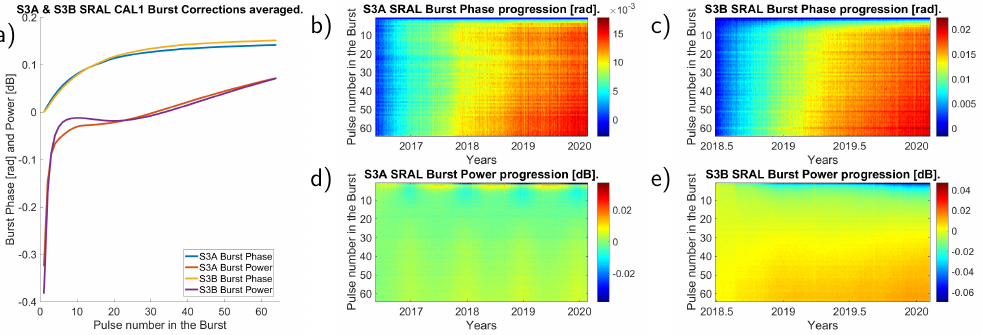
Figure 6. Complete mission averaged CAL1 Intra-burst correction of S3A and S3B: ( a ) averaged mission series, ( b , d ) S3A burst corrections progression with respect to first record, and ( c , e ) S3B burst corrections progression with respect to first